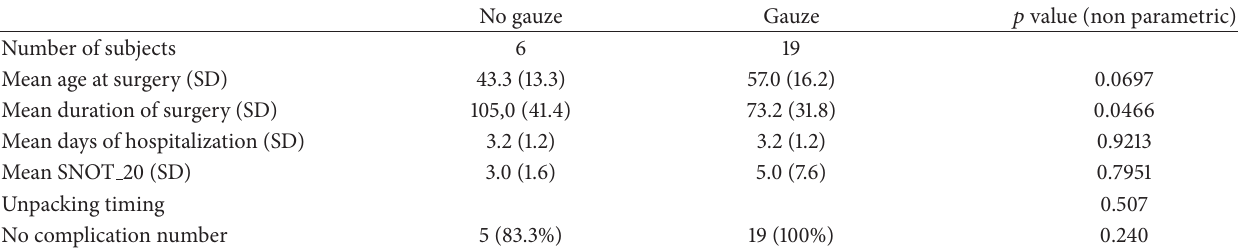
Table 2: Statistical